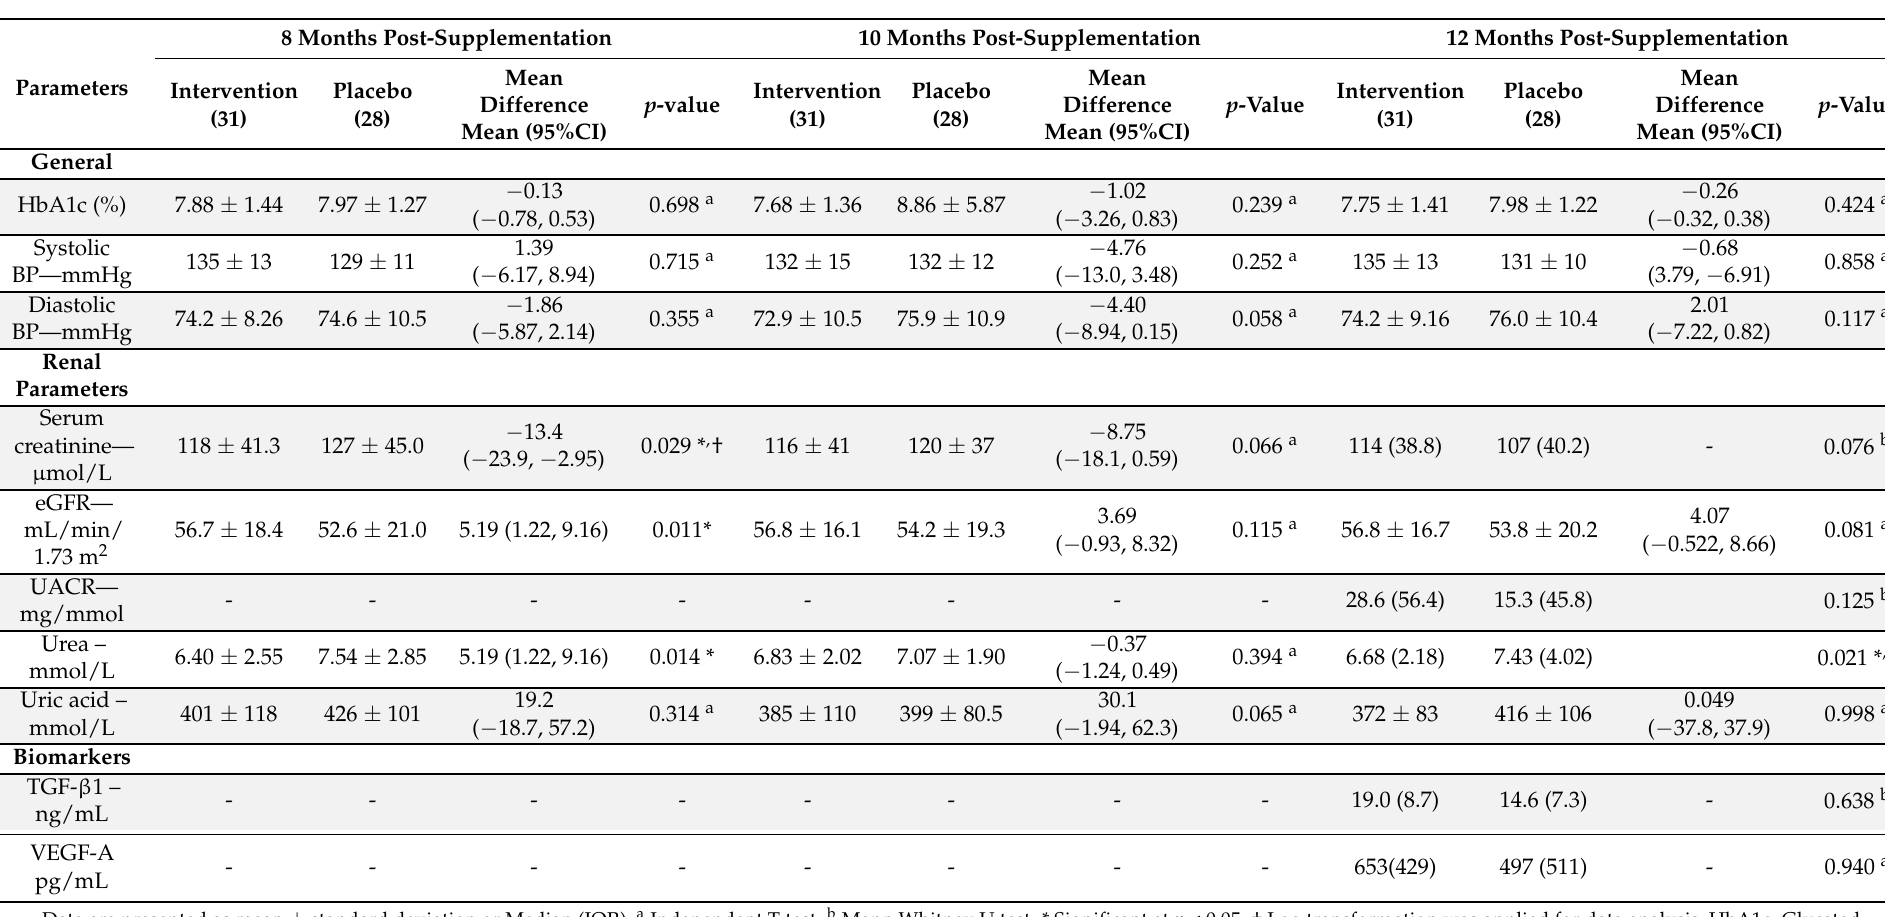
Table 3. Comparison between intervention and placebo group after twelve months of tocotrienol-rich vitamin E